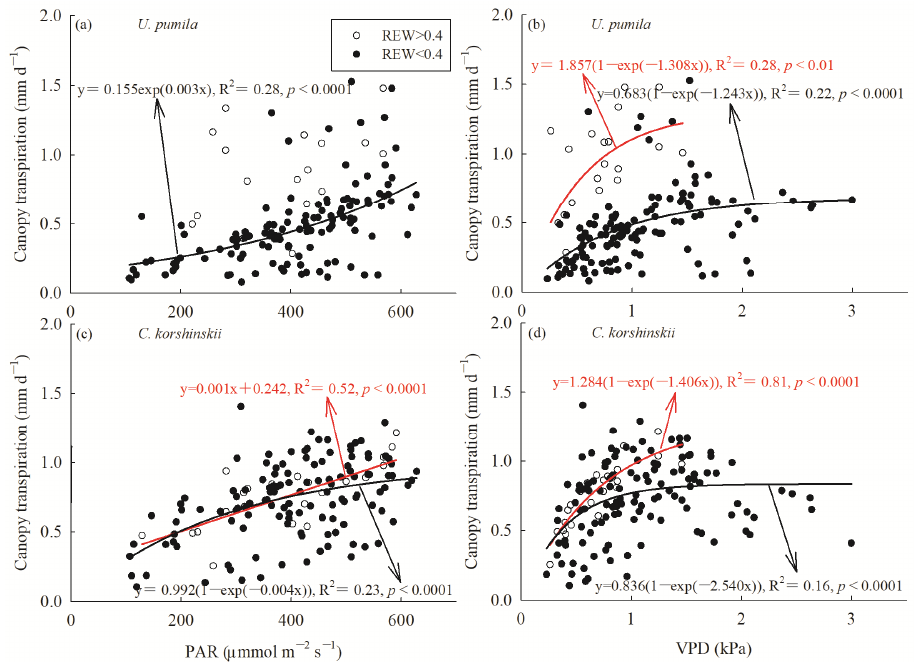
Figure 6. Relationships between canopy transpiration per ground area and daily environmental variables for U. pumila and C. korshinskii under stressed (REW < 0.40) and non-stressed (REW > 0.4) conditions across the measurement periods of 2020: ( a , c ) photosynthetically active radiation; ( b , d ) vapor pressure deficit.